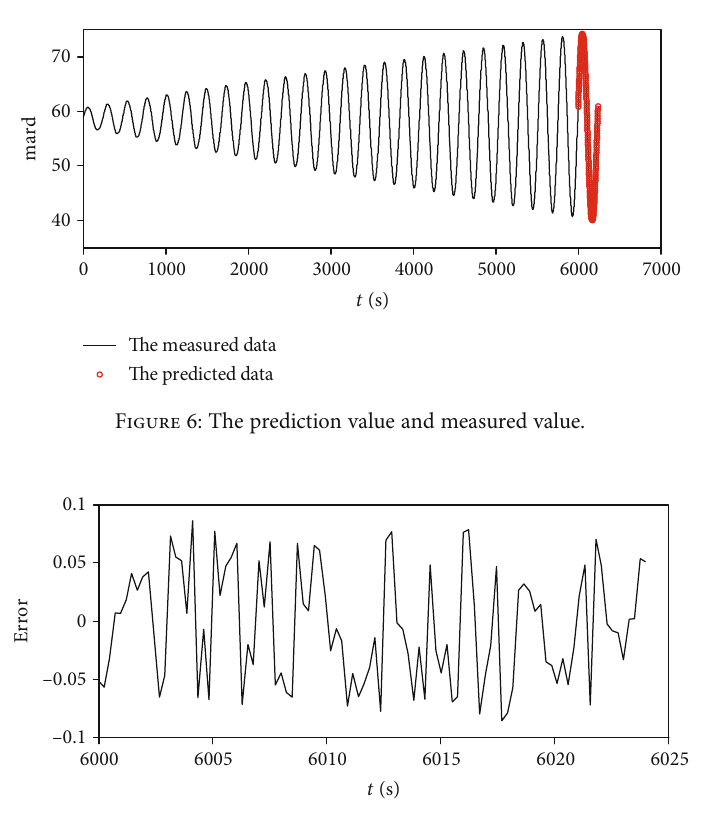
Figure 7: The error between the predicted value and measured